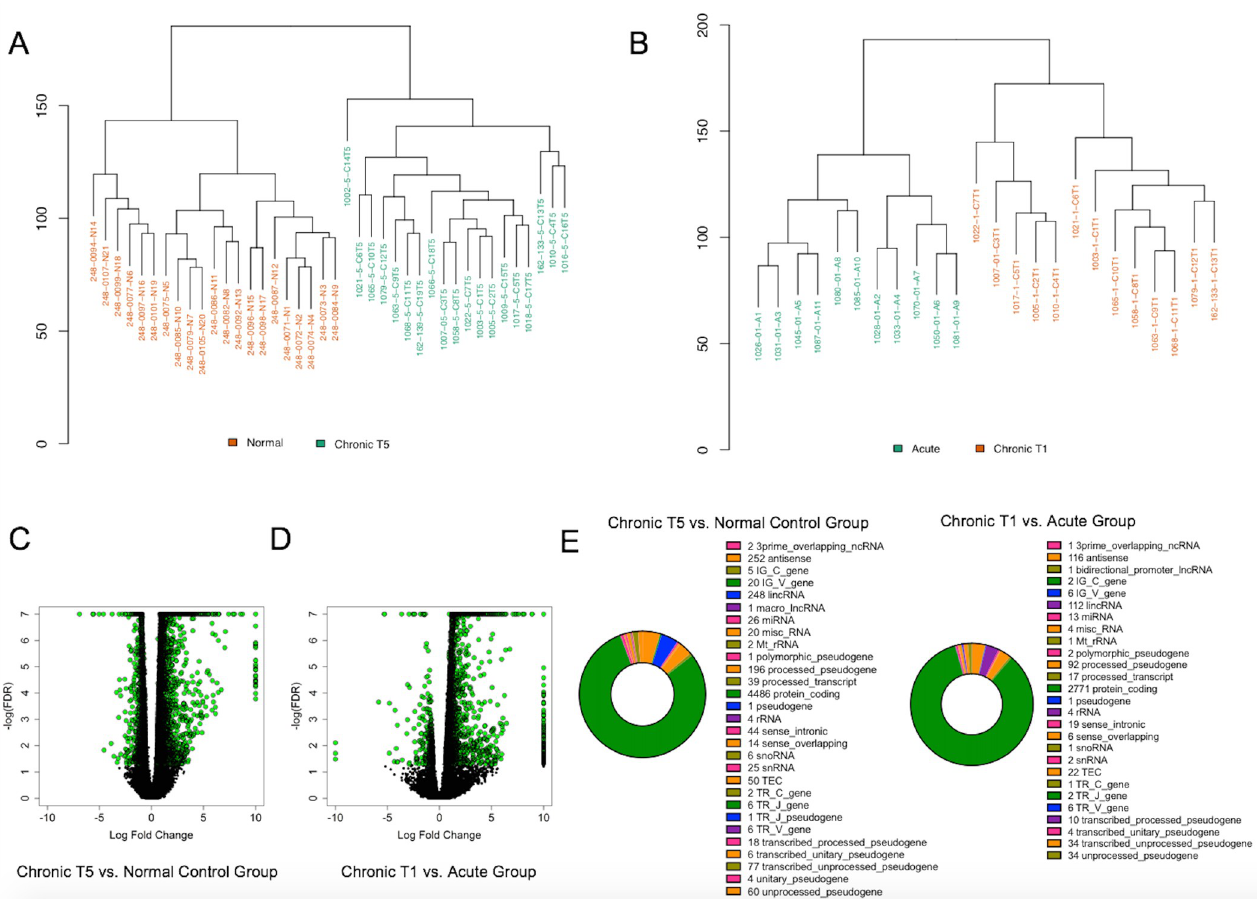
Fig 1. Characterization of differential gene expression in whole blood from the chronic T5 versus normal (healthy pain-free) group and in the chronic T1 and acute group. (A) Euclidean clustering demonstrates separation between the chronic T5 group compared with the normal control group. (B) Euclidean clustering demonstrates separation between the acute and chronic T1 group. (C) Volcano plot showing log fold change (LFC) for significantly differentially expressed genes (LFC ± 0.58; FDR p-value � 0.05; N = 3,479 shown in green circles) in the chronic T5 versus normal group. (D) Volcano plot showing log fold change (LFC) for significantly differentially expressed genes (LFC ± 0.58; FDR p-value � 0.05; N = 3,288 shown in green circles) in the chronic T1 compared with the acute group. (E) Pie charts depicting protein-coding and non-coding gene types for chronic T5 versus normal group (left) and chronic T1 versus acute group